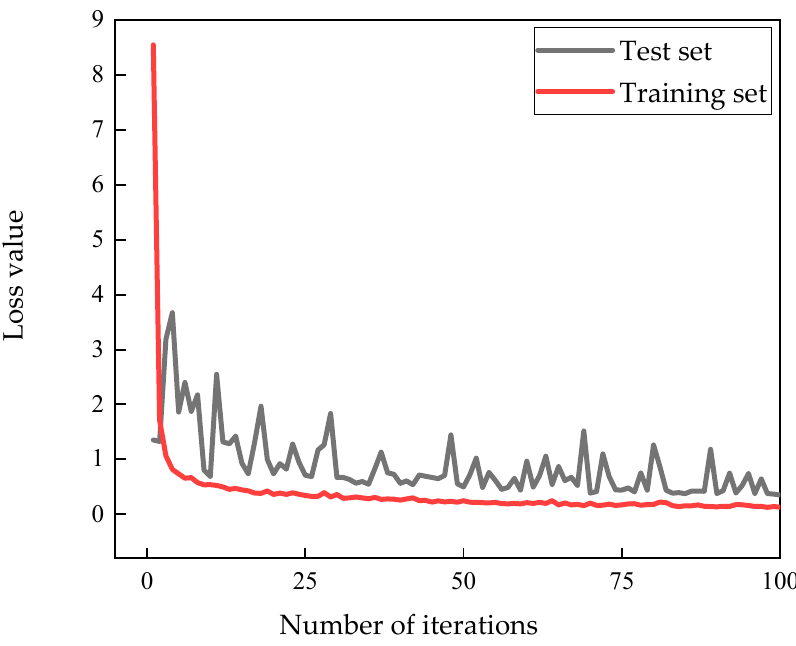
Figure 12. Loss function of the CNN-LSTM model at UP17 measurement